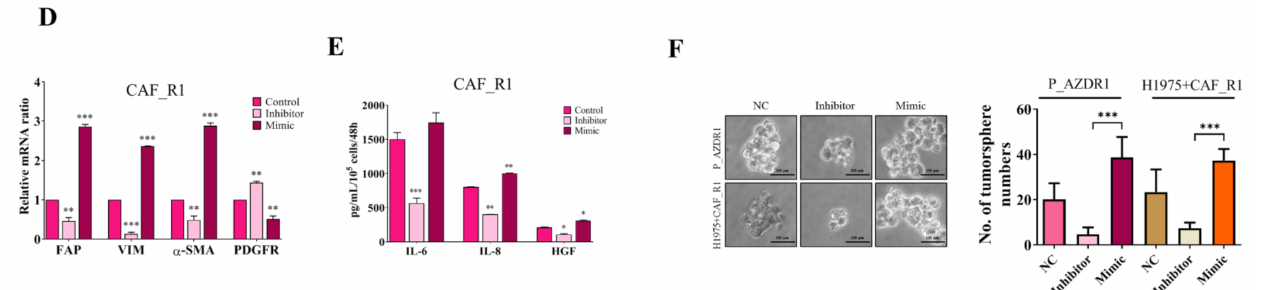
Figure 4. ( A ) Schematic representation of the interaction of the ERK/miR-21 signaling proteins by STRING analysis and PDCD4 was identified. ( B ) TCGA database analysis of 512 lung cancer patients showed a negative correlation between the expression of miR-21-5p and PDCD4. ( C ) PDCD4 was predicted as a target of miR-21-5p. The insert shows the miR-21-5p binds to the 3 (cid:48) -UTR of PDCD4. Western blots showed a decreased expression of MEK1/2, STAT3, ERK1/2, and PDCD4 in miR-21-5p inhibitor (I) treated lung cancer cells and the overexpression of miR-21-5p (M) showed the reverse and bar graph of multiple experiments. ( D ) Real-time PCR analysis showed that CAF_R1 cells with silenced miR-21-5p expressed a significantly lower level of FAP, A-SAM, VIM, and PDGFR. ( E ) CAF-associated cytokines, IL-6, IL-8, and HGF were also significantly reduced in the CAF_R1 cells with silenced miR-21-5p. ( F ) Tumor sphere formation assay. In both miR-21-5p inhibitor-treated P_AZDR1 and H1975-CAF_R1 cells, a significantly lower number of spheres was formed while mimic treatment reversed this phenomenon. * p < 0.05; ** p < 0.01; *** p < 0.001. Scale bar: 100 µ